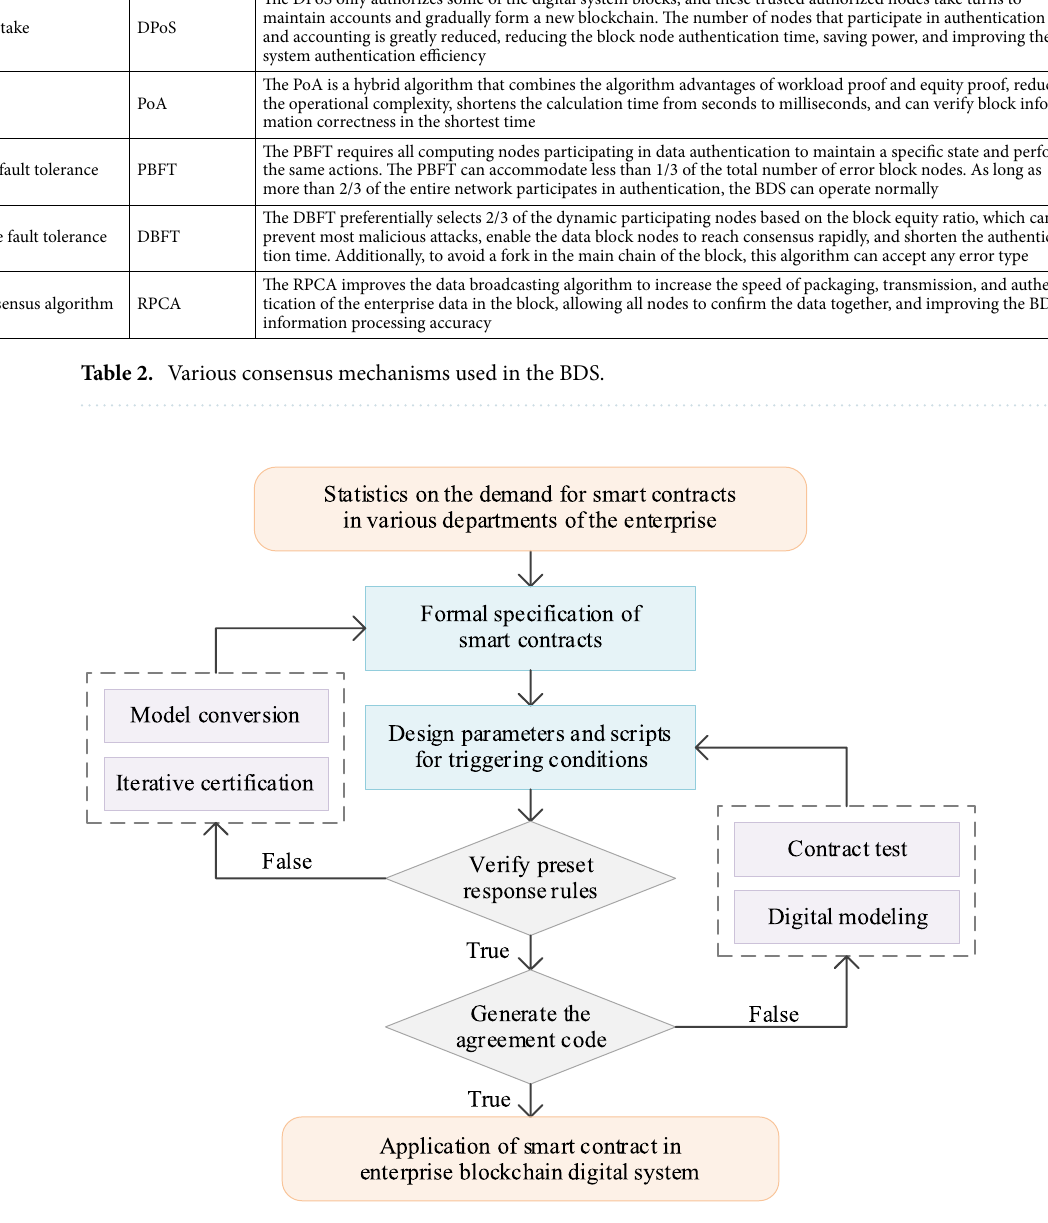
Figure 6. Data processing flow for smart